Question: Sum up the contents of this chart in one sentence.
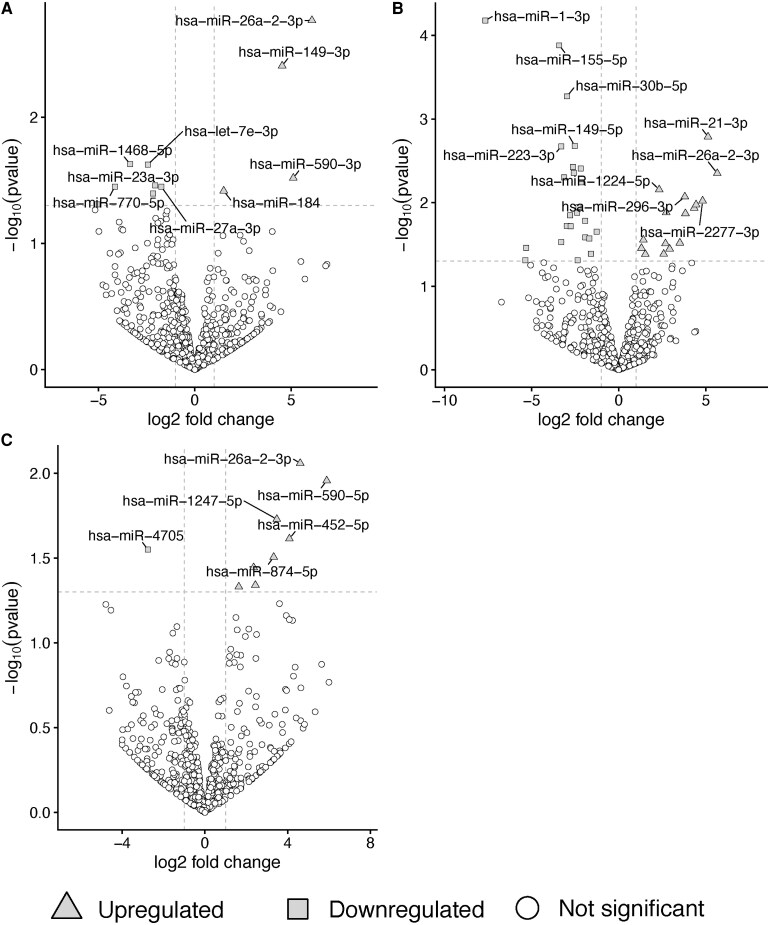
Answer: Microenvironment variation of AD BDsEV miRNA cargoes compared with FTD mutation samples. Volcano plots displaying the differentially expressed human (hsa) miRNA in AD BDsEVs compared with ( A ) FTD- GRN , ( B ) FTD- MAPT and ( C ) FTD- C9orf72 BDsEV cargoes, with log2FC plotted against log10 p values. DESeq2 was ran in R which applies a negative binomial generalized linear model with Wald testing (sample size n = 3, biological replicates plotted). Nominally significant upregulated (triangle plot), downregulated (square plot) and not significant (circular) miRNAs are plotted, as no miRNAs survived FDR testing (with the top 5 up and downregulated miRNA labelled). Dashed lines represent log2FC of 1 and −1 and a −log10p of 1.3 ( P < 0.05).